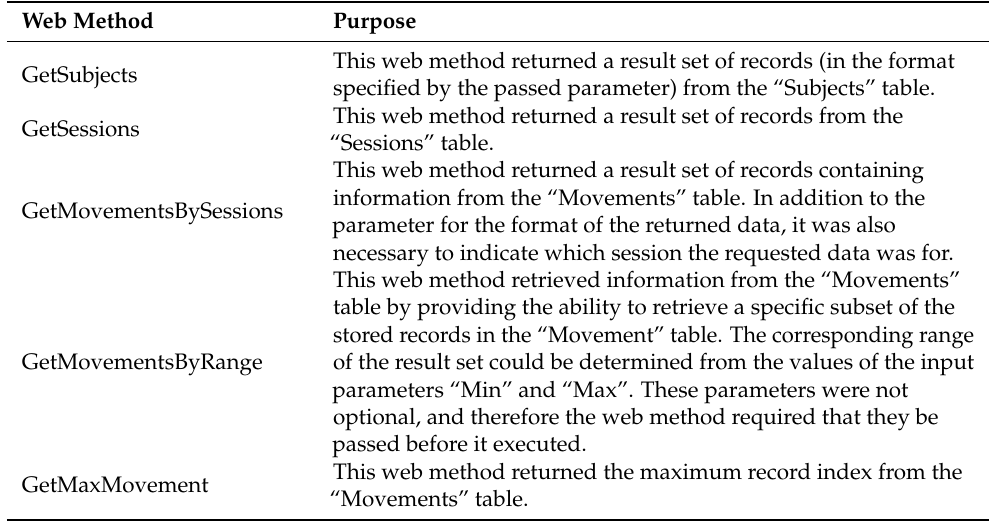
Table 2. Web methods provided by the MVSEM web